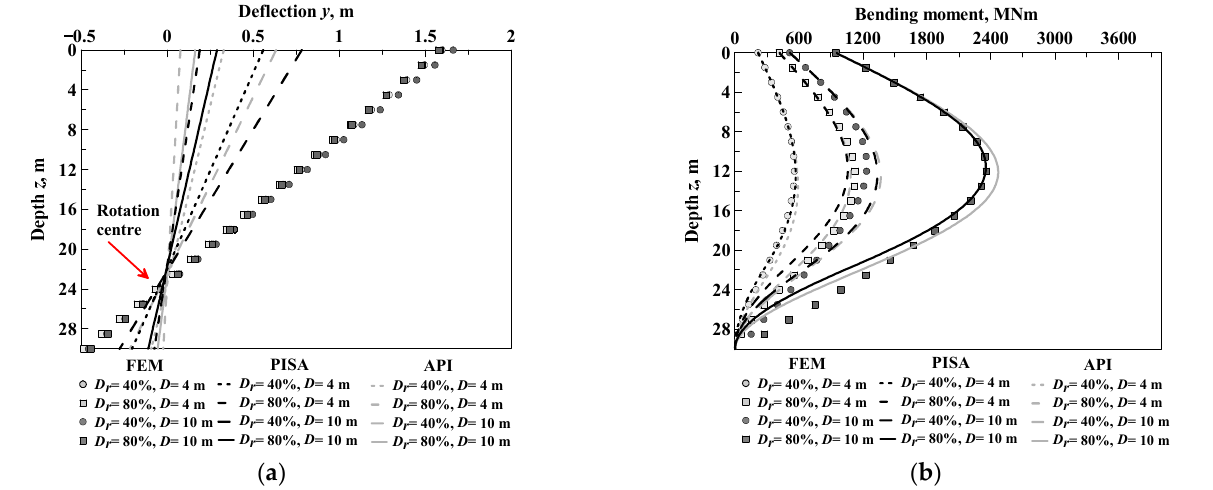
Figure 17. Deflection and bending moment profiles in 40% and 80% relative density sands under a loading eccentricity of 5 m: ( a ) deflection profile, ( b ) bending moment profile.